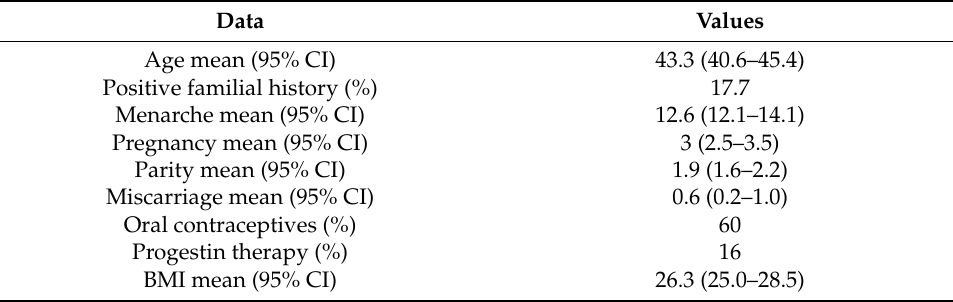
Table 1. Clinical data of enrolled patients with